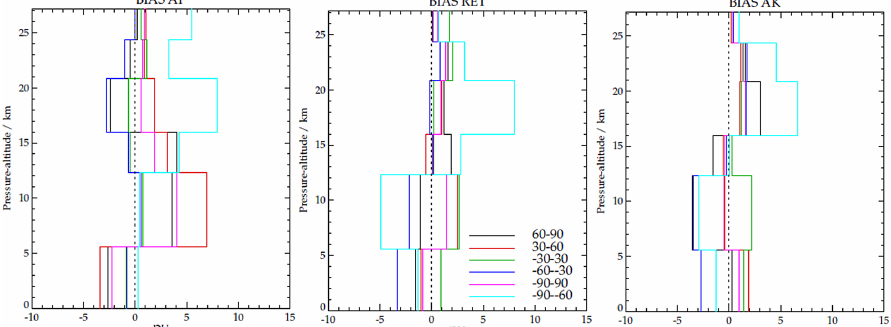
Figure 7. Bias with respect to ozonesondes as a function of latitude and pressure for subcolumns in Dobson units for the a priori (left) and retrieved (centre) profiles and for retrieved profiles with GOME-2 AKs applied to the sonde profiles (right). The pink lines indicate the averages over all latitude bands, for comparison to the black and green lines in the left hand panel of Fig. 4, which depict the same a priori and retrieval biases as % differences from the ozonesondes.